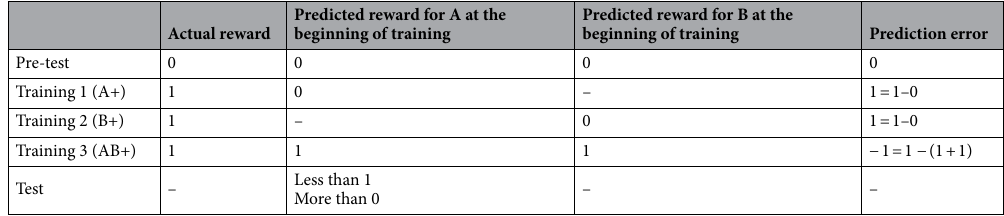
Table 2. Prediction based on the Rescorla and Wagner model for overexpectation. To simplify the predictions, we assume that λ = 1 and that each of the trainings provides a sufficient effect to achieve conditioning.